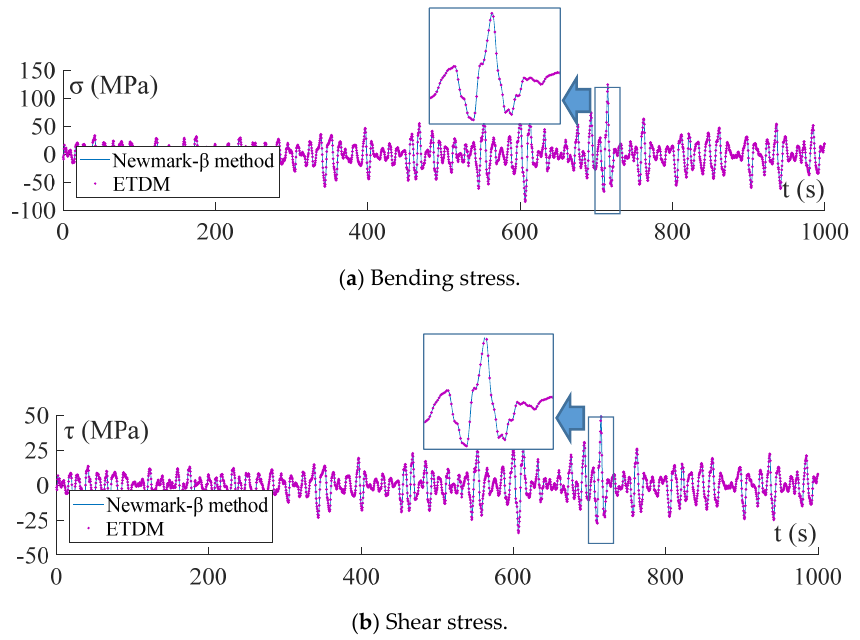
Figure 10. Bending and shear stress at the bottom of a battered leg of the jacket platform.